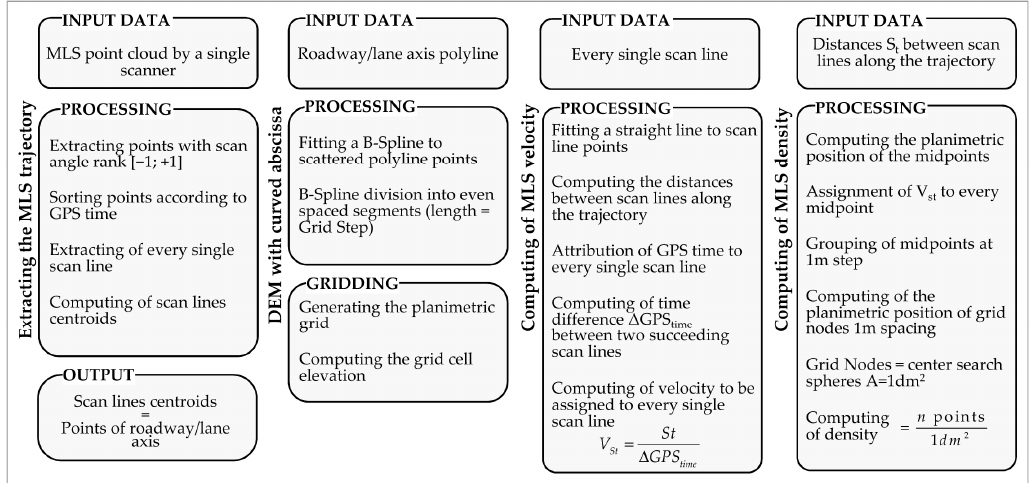
Figure 1. Data-processing schematic.